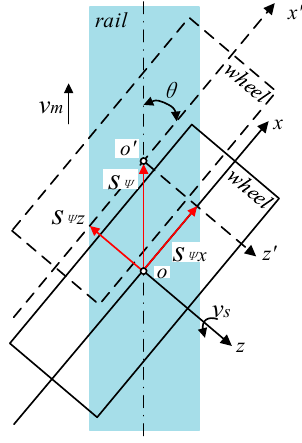
Figure 5. Schematic diagram of grinding wheel end face deflection, θ movement. Combined with Figures 4 and 5, xOy coordinate system is established at the point A where abrasive grains start grinding, and the motion track equation of the grinding wheel relative to the rail is established in Equation (3) [27]. See Section 7 (Nomenclature) for the parameters involved in the following calculation, where “+” means up-grinding of the grinding wheel, and “ − ” means down-grinding of the grinding wheel.